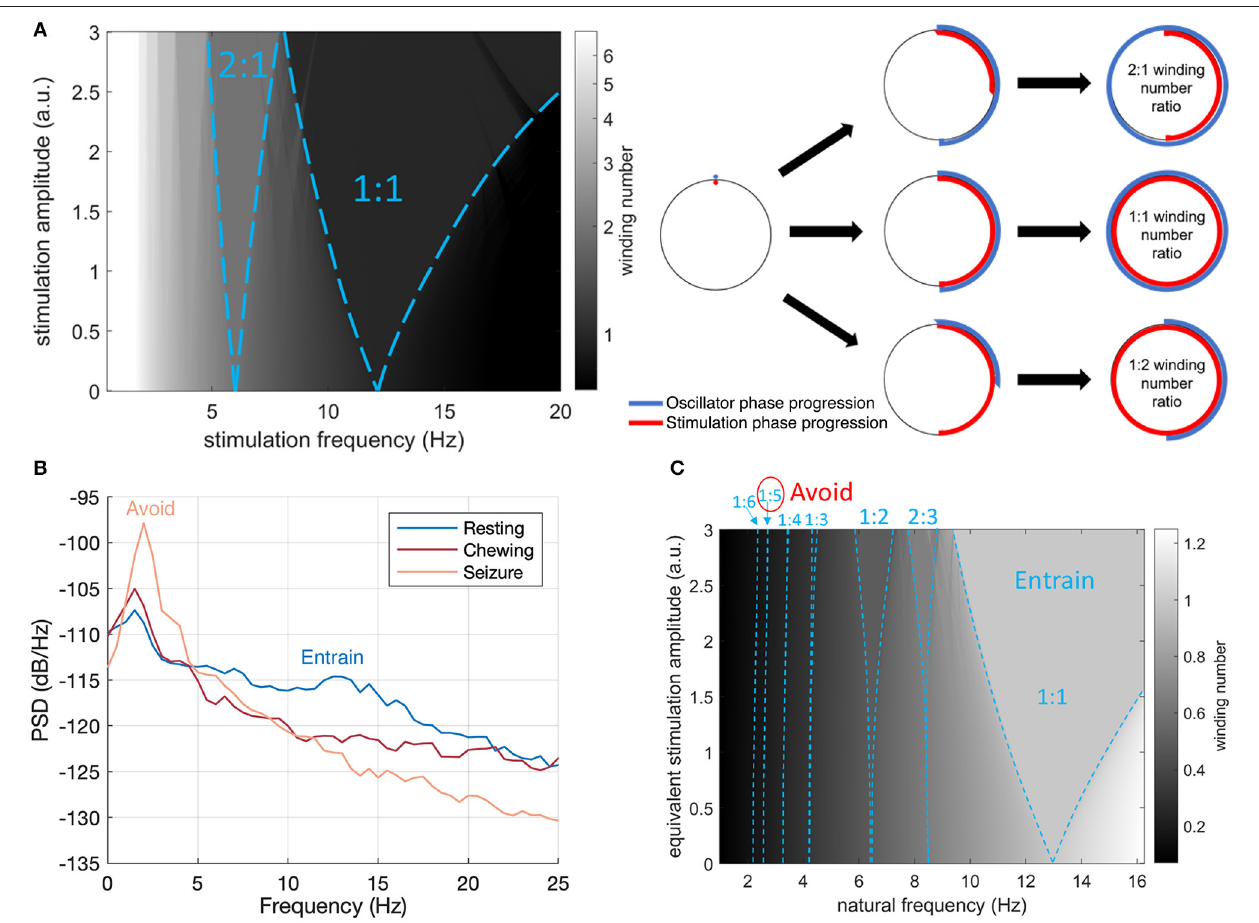
FIGURE 2 | Arnold Tongues and Stimulation Frequency Strategy. (A) Winding number and Arnold tongues in the sine circle map as a function of stimulation (driver) frequency and amplitude for an oscillator with a natural frequency of 13Hz. Arnold tongues correspond to areas of constant winding number. The 1:1 tongue (winding number of 1) and the 2:1 tongue (winding number of 2) are highlighted with blue dashed lines. For stimulation parameters falling within the p:q tongue, the rhythm will + I sin θ i , where θ i is the oscillator phase right after be entrained at p/q times the stimulation frequency. The sine circle map was simulated as θ i + 1 = θ i + 2 π (cid:16) f 0 f s (cid:17) stimulation pulse i , f 0 is the natural frequency of the oscillator, f s is the stimulation frequency and I is the stimulation amplitude. The winding number was calculated over 20 trials with random initial phases θ 0 uniformly distributed between 0 and 2 π . (B) Intracranial field after N = 50 stimulation pulses as the average of ( θ N − θ 0 ) ( 2 π N ) potentials from the implanted signals (left hemisphere, contacts 0–3) remotely accessed through wireless telemetry. Representative signals were gathered during different activities of daily living to characterize frequency content. The stimulation therapy strategy aims to entrain the healthy rhythm around 13Hz, while avoiding the peak at 2Hz observed during seizure. (C) Illustration of the final stimulation strategy. The winding number in the sine circle map is shown here for a fixed stimulation frequency (13Hz) as a function of natural frequency (e.g., inherent thalamocortical rhythm) and stimulation amplitude. Selected Arnold tongues are highlighted in blue. Stimulation at 13Hz can reliably entrain the desired 12Hz thalamocortical oscillation (large 1:1 tongue) while avoiding induction of pathological tongues in the region of 2–3Hz. The 1:5 and 1:6 tongues obtained from 13Hz stimulation are indeed so narrow that they will not lead to any entrainment in practice. To account for the fact that neural oscillations at lower frequencies typically have higher power ( 1 / f power law) and would therefore require more energy to entrain, the vertical axis represents equivalent stimulation amplitude (stimulation amplitude multiplied by f 0 / f max , where f 0 is the natural frequency and f max the maximum frequency shown). This is conservative as the 1:5 and 1:6 tongues disappear at higher stimulation